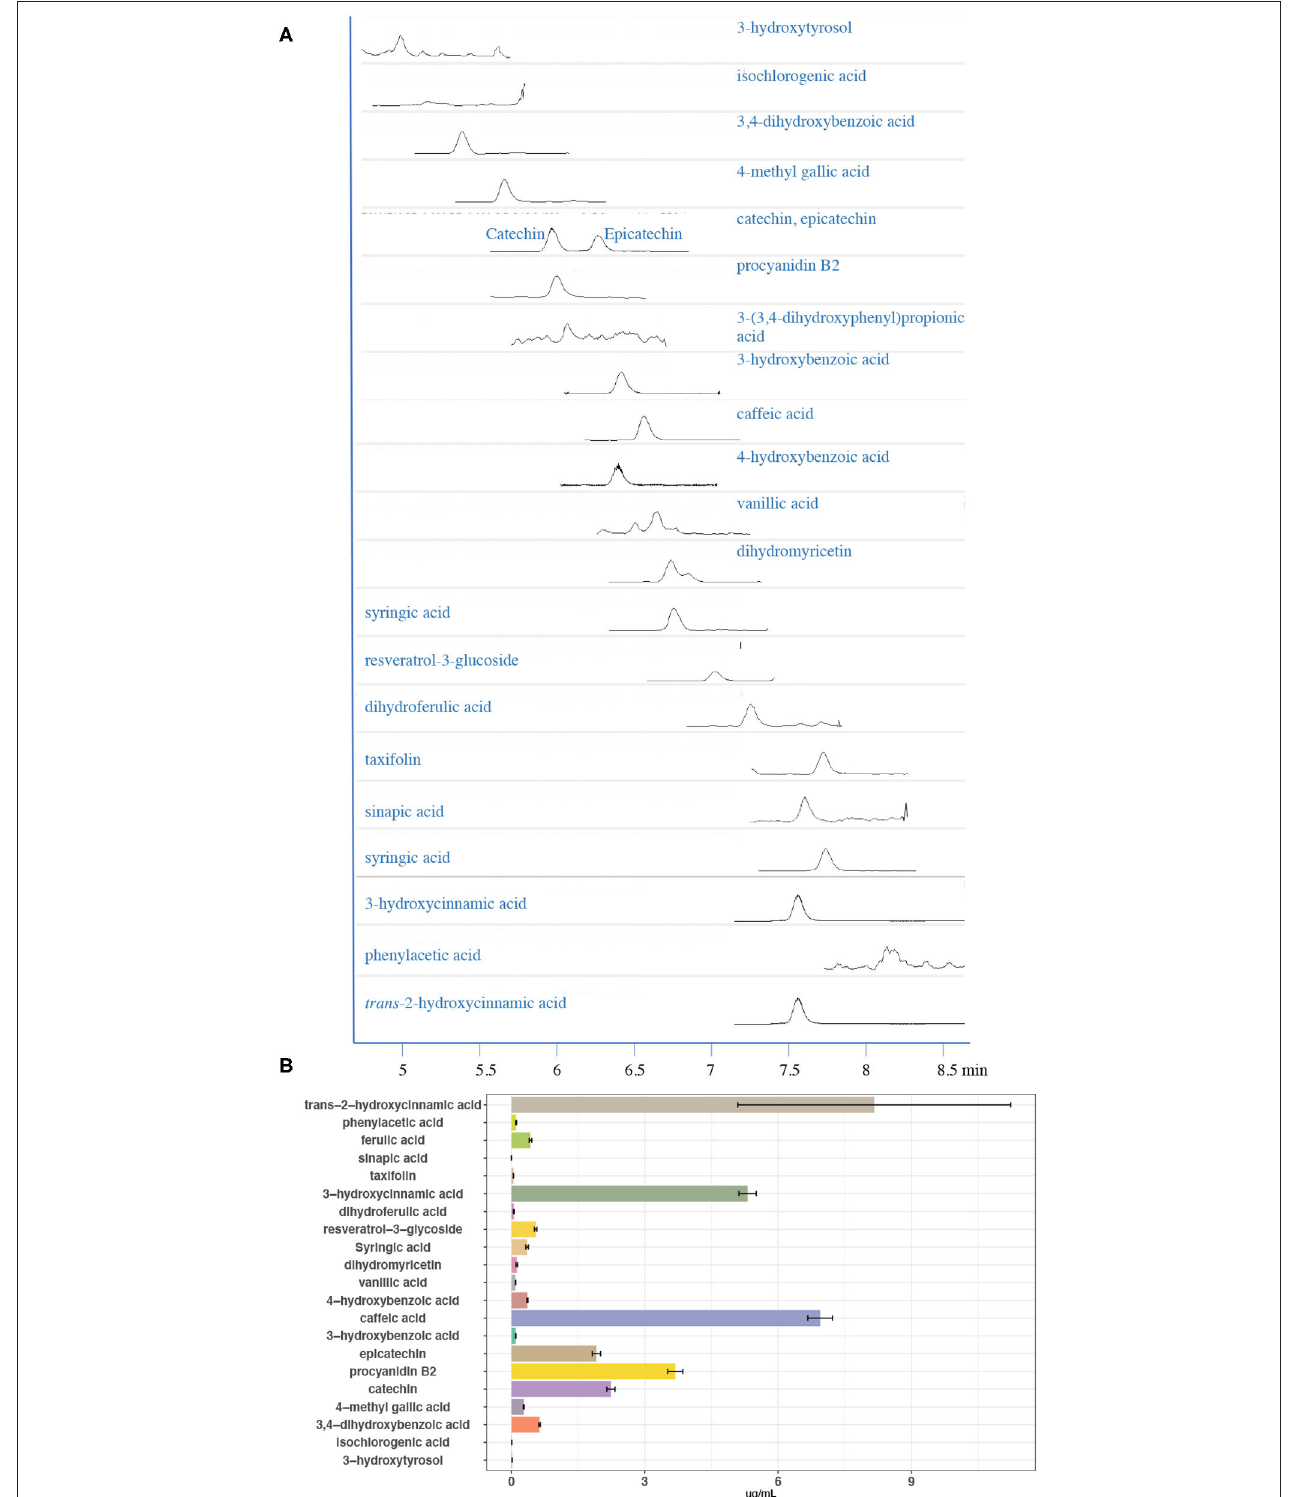
FIGURE 5 | (A) Mass spectrometry (MS) chromatographs of CGJ and (B) the content of targeted compounds in CGJ.